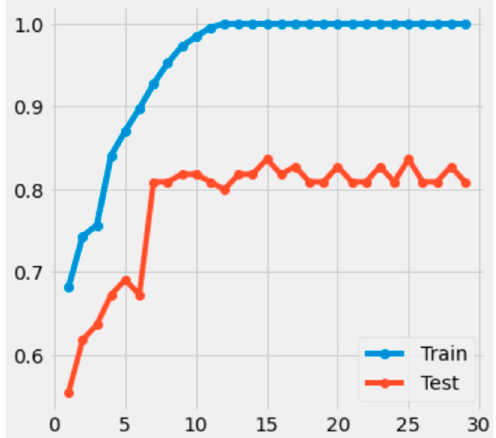
Figure 17. Different maximum depth sizes for decision tree algorithm.